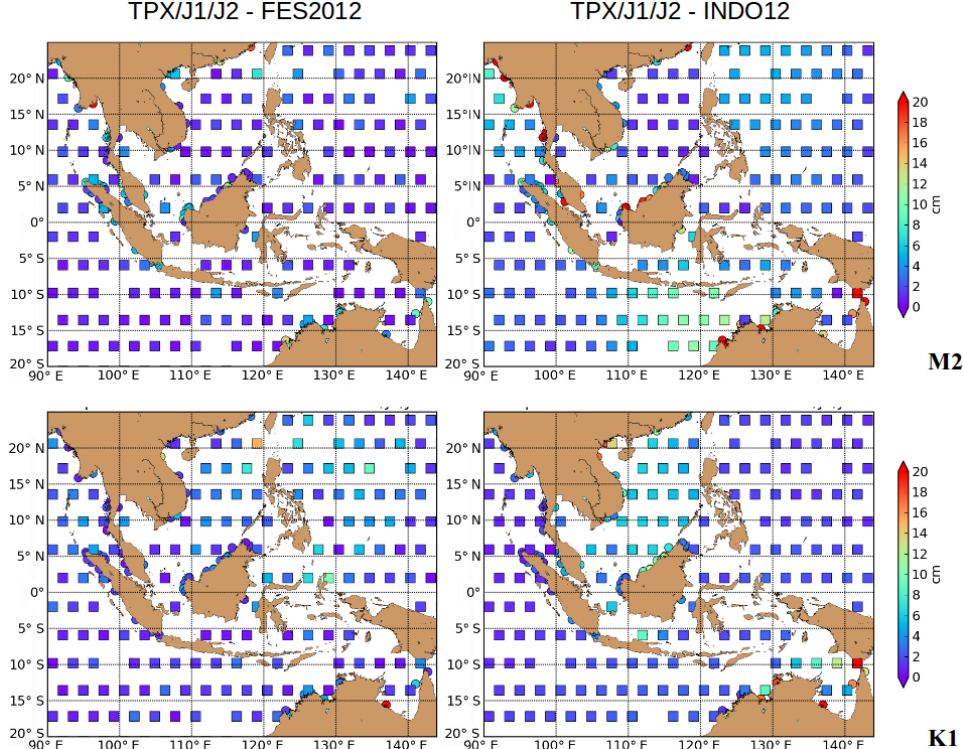
Figure 5. Surface tidal elevation complex differences at crossing points between TPX/J1/J2 and FES2012 (left) and INDO12 (right) sym- bolised by squares. Surface tidal elevation complex differences between tide gauges and FES2012 (left) and INDO12 (right) symbolised by circles. Units are in centimetres. M2 (top) and K1 (bottom) tidal